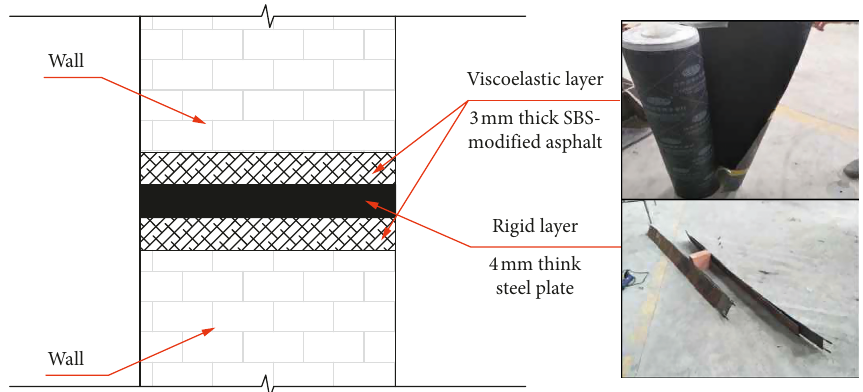
Figure 4: Schematic diagram of damping layer construction.